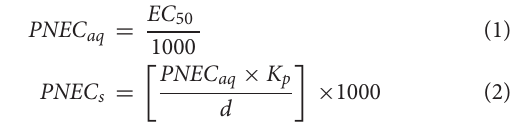
outlined by the European Medicine Evaluation Agency